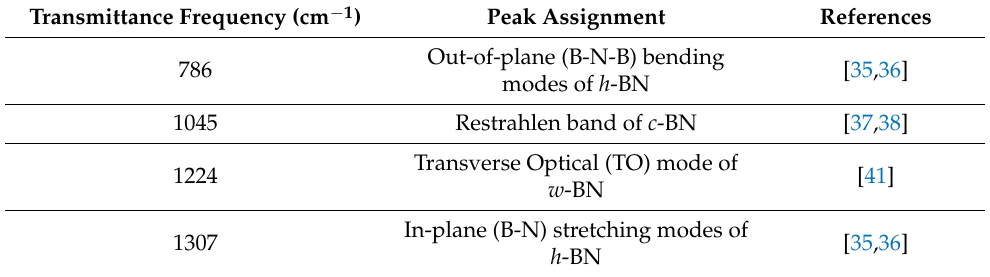
Table 1. Complete peak assignment for the (FTIR) spectral analysis of the boron nitride coatings.